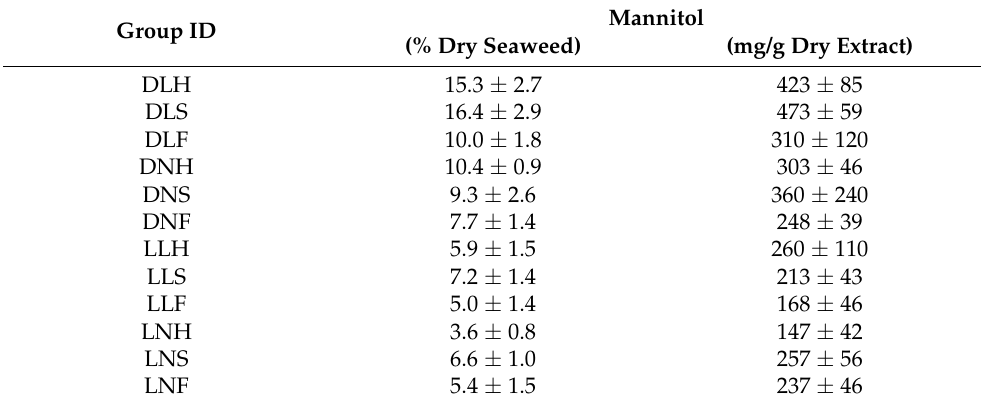
Table 5. Mannitol content of seaweed PHLE extracts expressed as a percentage of dry seaweed and on a dry extract basis. Data are means ± SD ( n = 5). Mannitol Group ID (% Dry Seaweed) (mg/g Dry Extract)